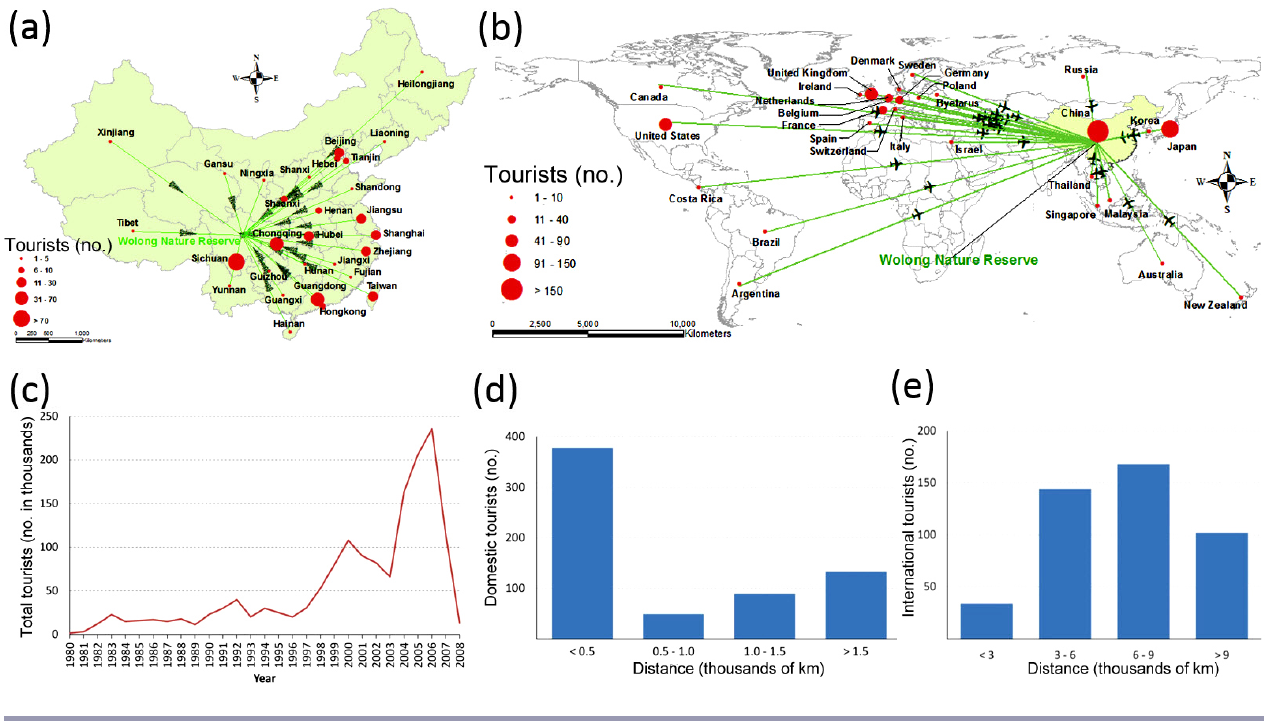
Fig. 3 . (a) Spatial distribution of sampled tourists to Wolong from other parts of China (2006–2007). (b) Spatial distribution of sampled tourists traveling to Wolong from other countries (2006–2007). (c) Changes in the total numbers of tourists to Wolong over time. (d) Number of sampled Chinese domestic tourists at different distances between their origins and Wolong (2006–2007). (e) Number of sampled international tourists at different distances between their origins and Wolong